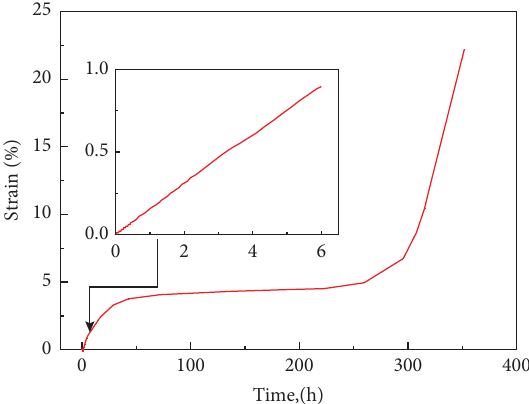
Figure 2: Creep curve of the alloy at 1040 ° C/137